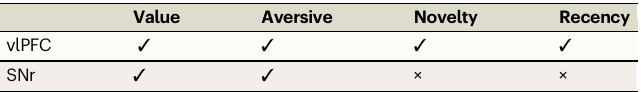
Table 1 | Summary of Salience memory coding in vlPFC and